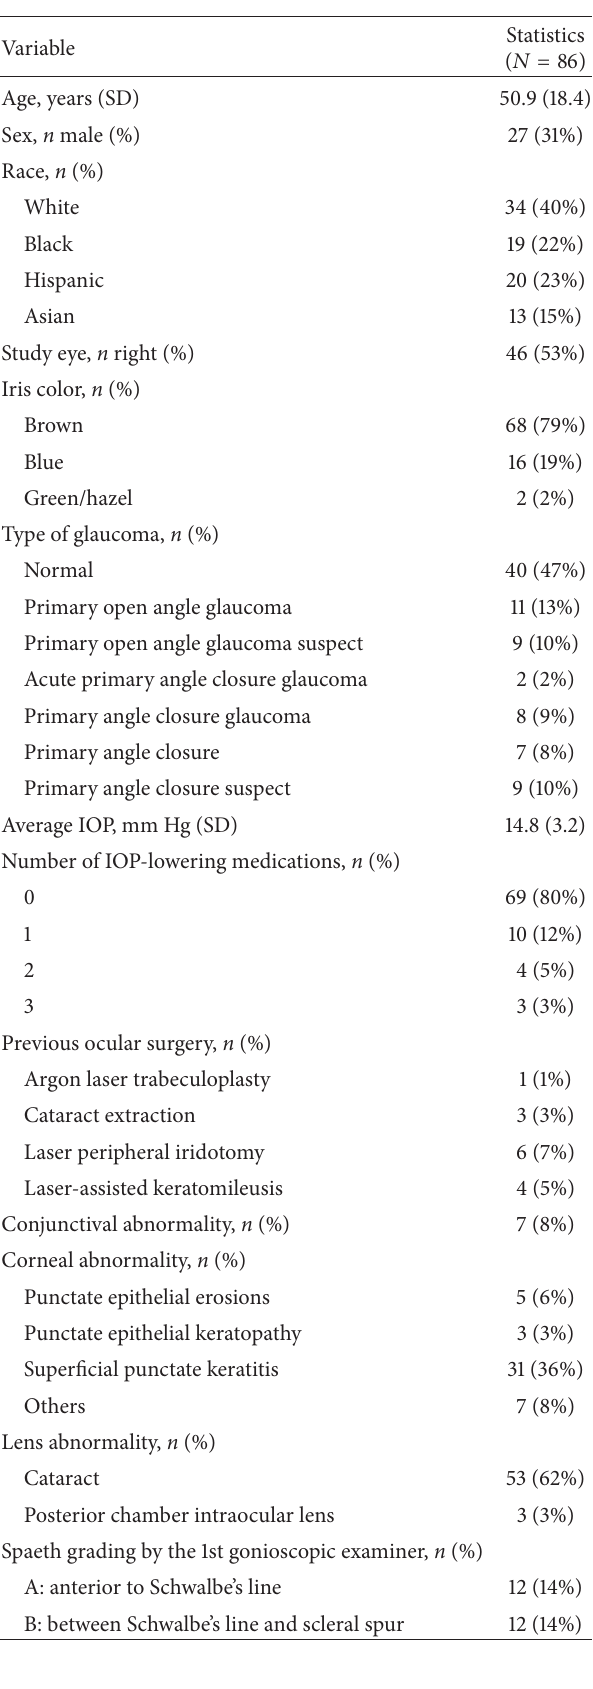
Table 1: Demographics and baseline ocular characteristics.